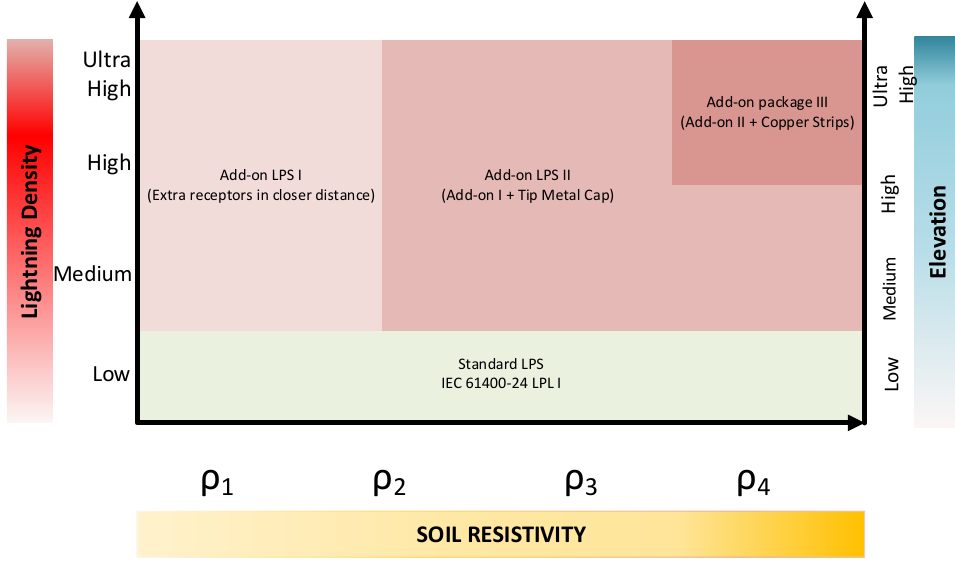
Figure 6. Lightning activity variation with altitude.